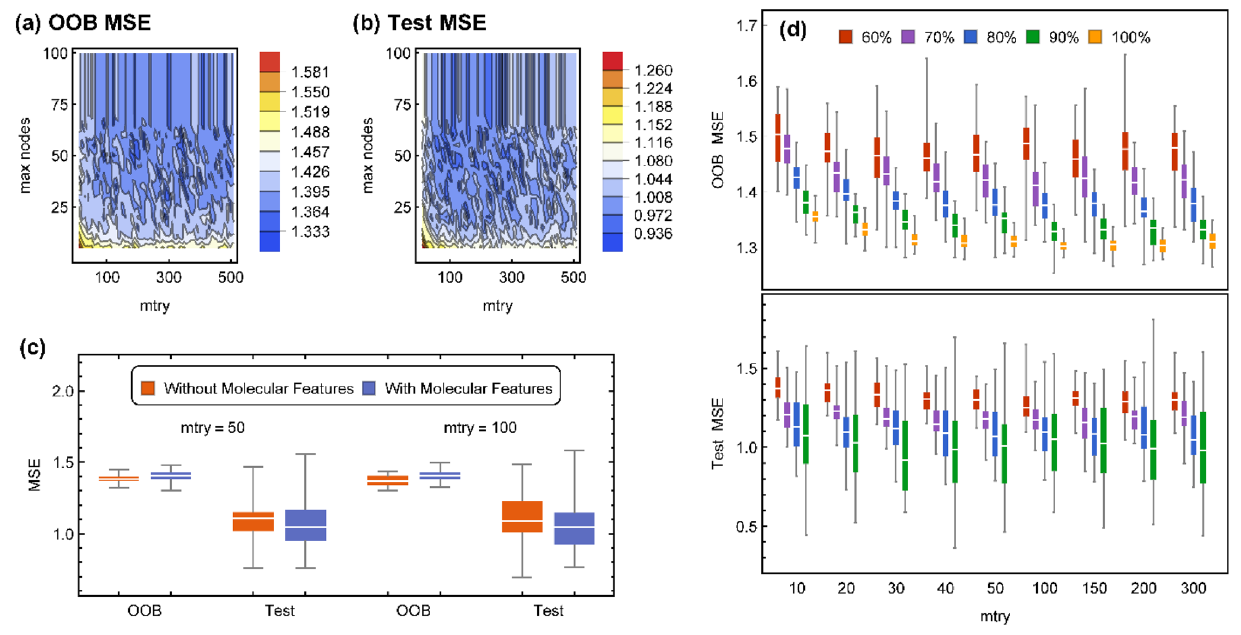
Figure 5. ( a , b ) OOB and Test MSE over a grid of different mtry and maxnode values while the number of trees is fixed at 500 and the data is split to 80% train and 20% test. ( c ) The effect of inclusion of molecular features on distribution of OOB and Test MSE obtained upon many random splits of data to 80% train and 20% test. ( d ) Trends of OOB and Test MSE as enlarging the test set from 30 to 100% of data and their dependence on mtry